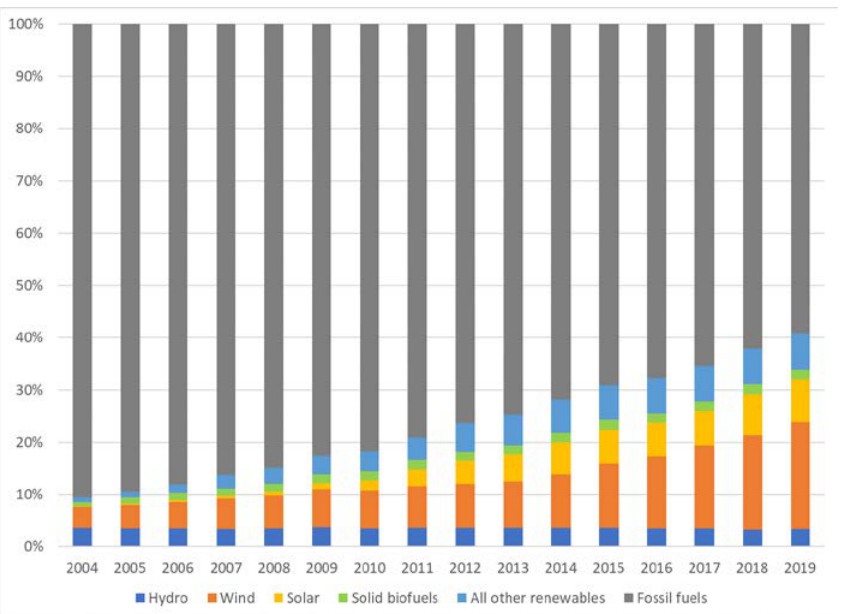
Figure 1. Electricity mix of Germany. Based on Eurostat shares data.